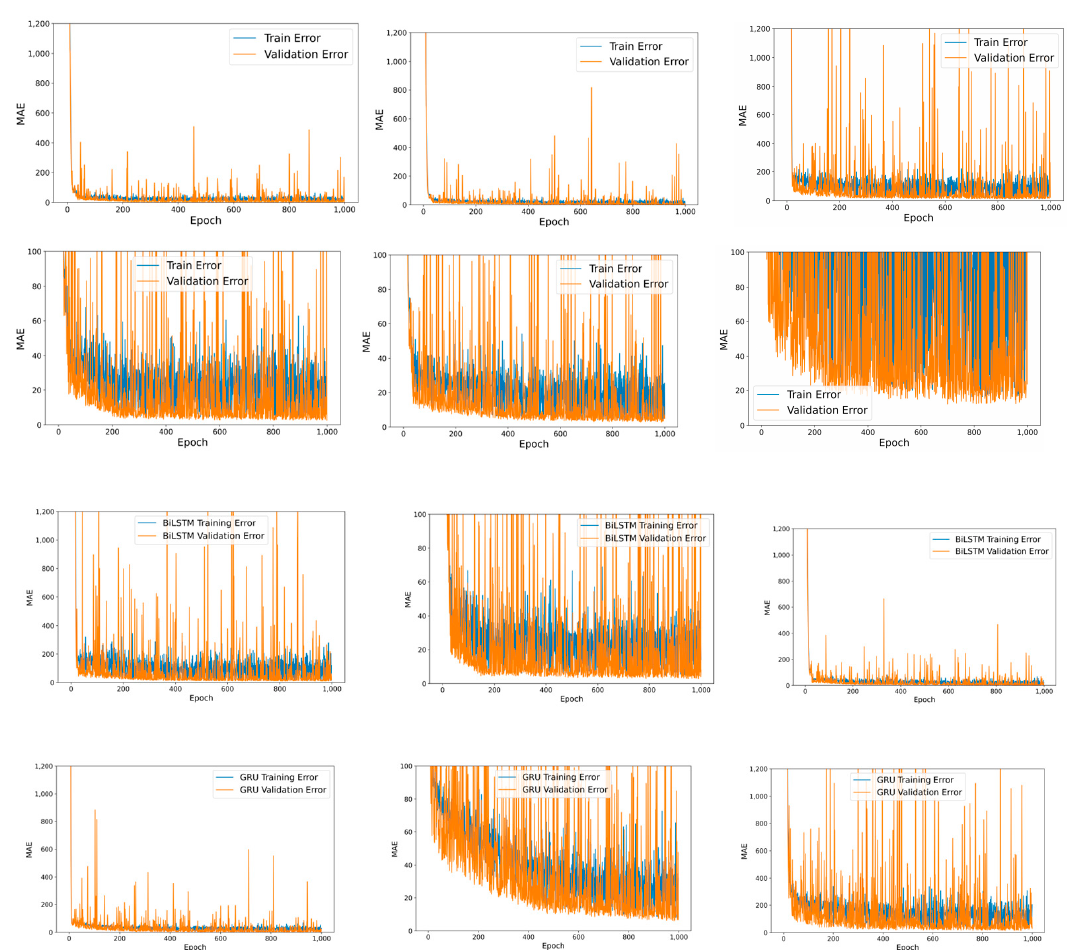
Figure 4. LSTM training performance of experiment 3. Figures in row 1 display LSTM results with a scale of 0–1200, and row 2 has a narrow scale of 0–100. Figures in row 3 show the BiLSTM result, and row 4 shows the GRU result. The Figures in sequential columns in each row indicate local 1,2, and 3. Compared to other experiments, the MAE of experiment 1 reveals to be lower than expected, with an average value of 58,202.96 (Local 1), 62,592.67 (Local 2), and 635,606.56 (Local 3) in LSTM. Local 3 shows the worst performance, approximately ten times larger